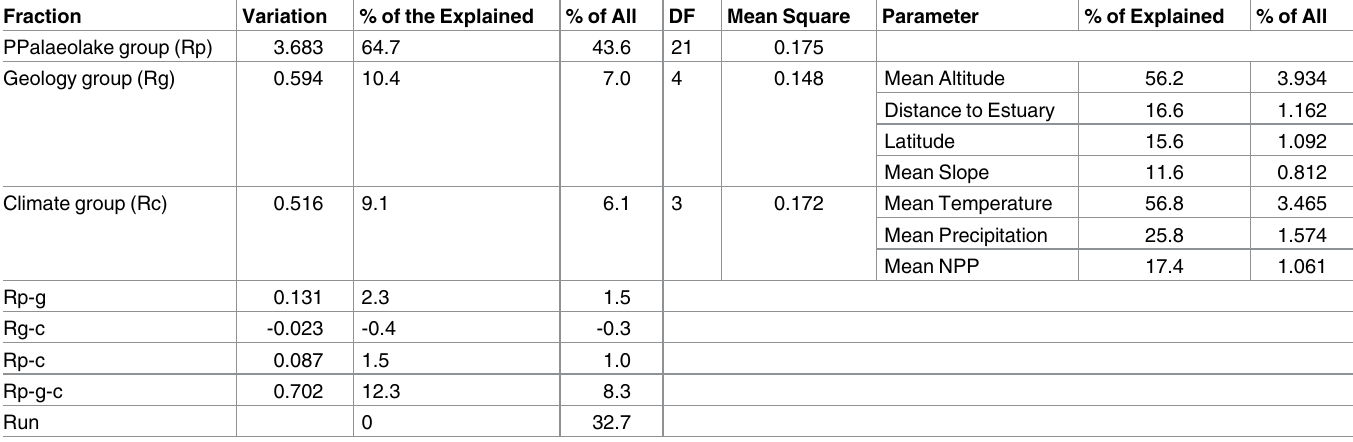
Table 1. Partitioning values of explanation on fish biogeography at group and parameter scale. Rp, Rg and Rc mean the role of palaeolake, geology and climate respectively. Rp-g, interaction betweenpalaeolakeand geology; Rg-c, interactionbetweengeologyand climate; Rp-c, interactionbetween palaeolake and climate; Rp-g-c, interaction amongpalaeolake,geologyand climate; ‘% of all’ = ‘% of the explained’ × (1 − Run%). Fraction Variation % of the Explained % of All DF Mean Square Parameter % of Explained % of All PPalaeolake group (Rp) 3.683 Geology group